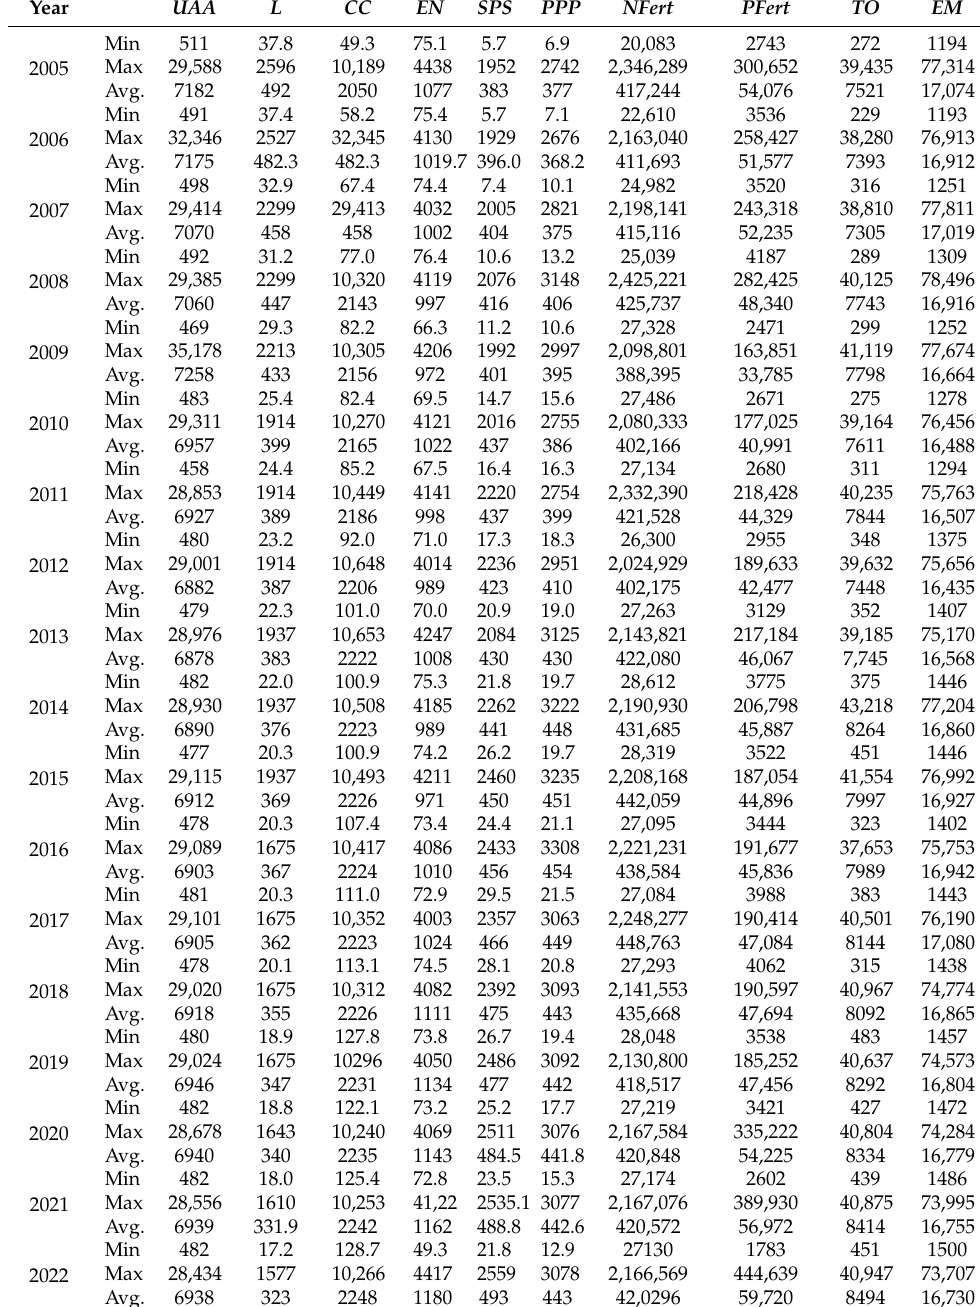
Table A1. Descriptive statistics of Inputs and Outputs for reference period 2005–2022.